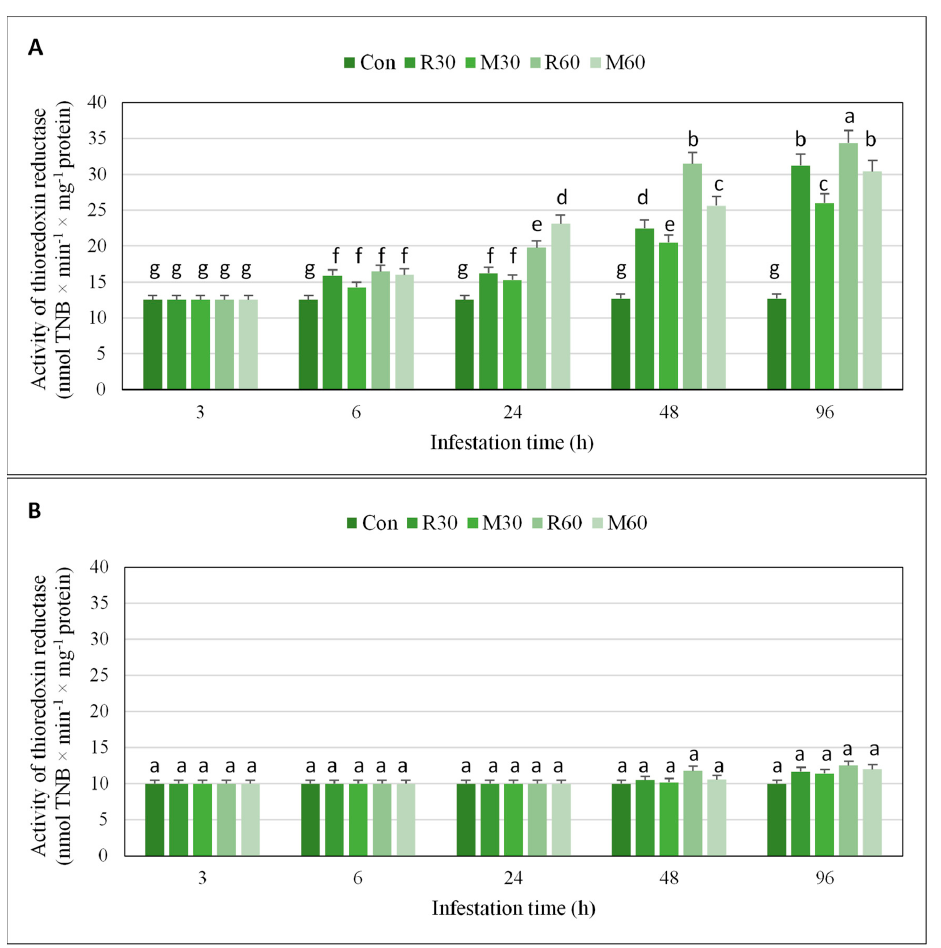
Figure 4. Impact of Rhopalosiphum padi and Metopolophium dirhodum aphid infestation on the total activity of thioredoxin reductase (TrxR) in the seedlings of two tested maize genotypes. ( A